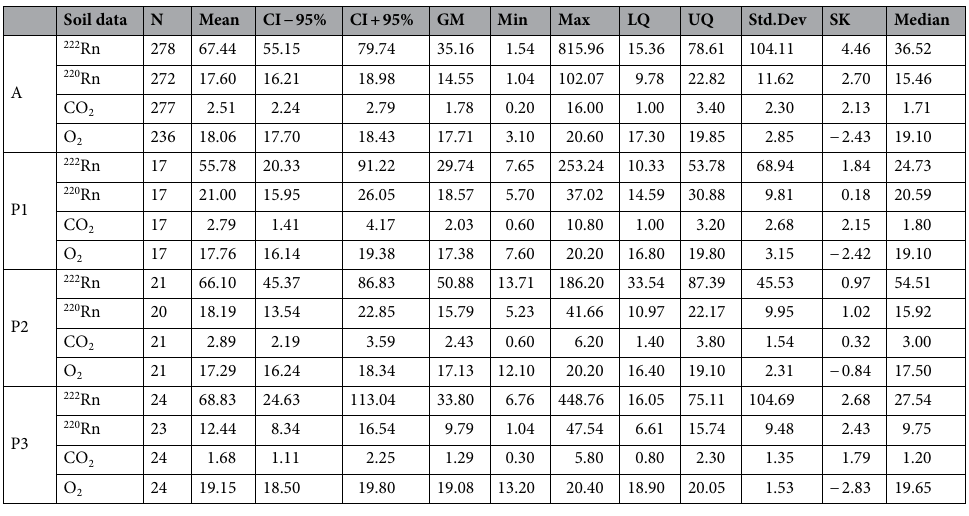
Table 1. Descriptive statistics of soil gas data. A = Total dataset; P1, P2, P3 = profiles; N Number of samples; Mean; CI (−95%—+ 95%) Confidence interval of the mean; GM Geometric mean; Min Minimum value; Max Maximum value; LQ Lower quartile; UQ Upper quartile; Std.Dev. Standard deviation; SK Skewness;